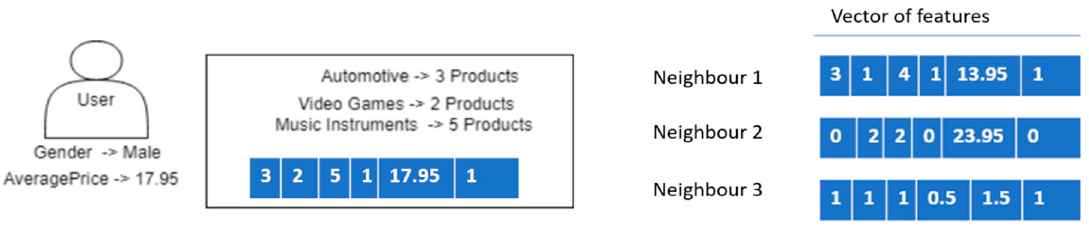
Figure 3. Creation of the vector of features to each Neighbour.